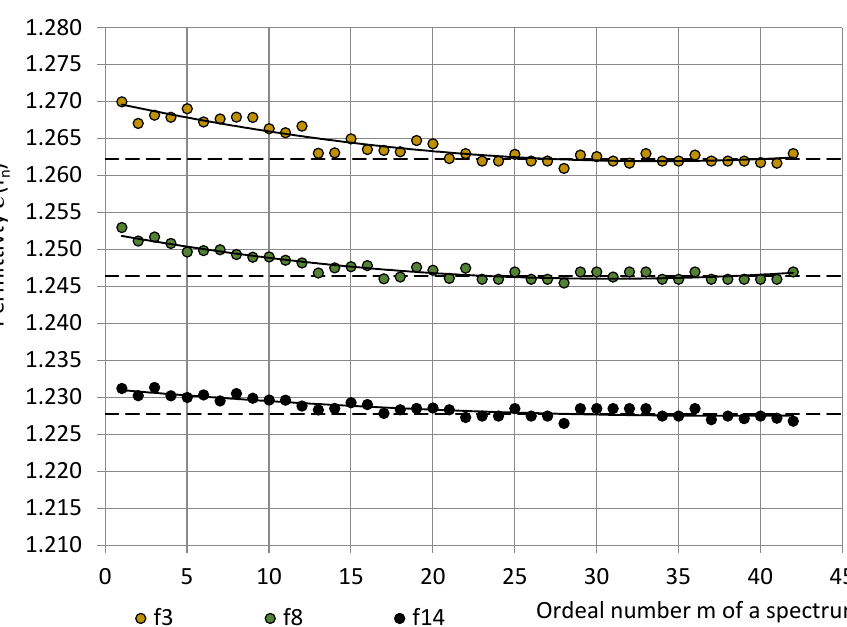
Figure 11. The permittivity of PU SikaBlock ® -M150 foams (density of 144 kg/m 3 ) in a long series at frequencies f 3 = 40 Hz (beige), f 8 = 1280 Hz (green), and f 14 = 81,920 Hz (Black).